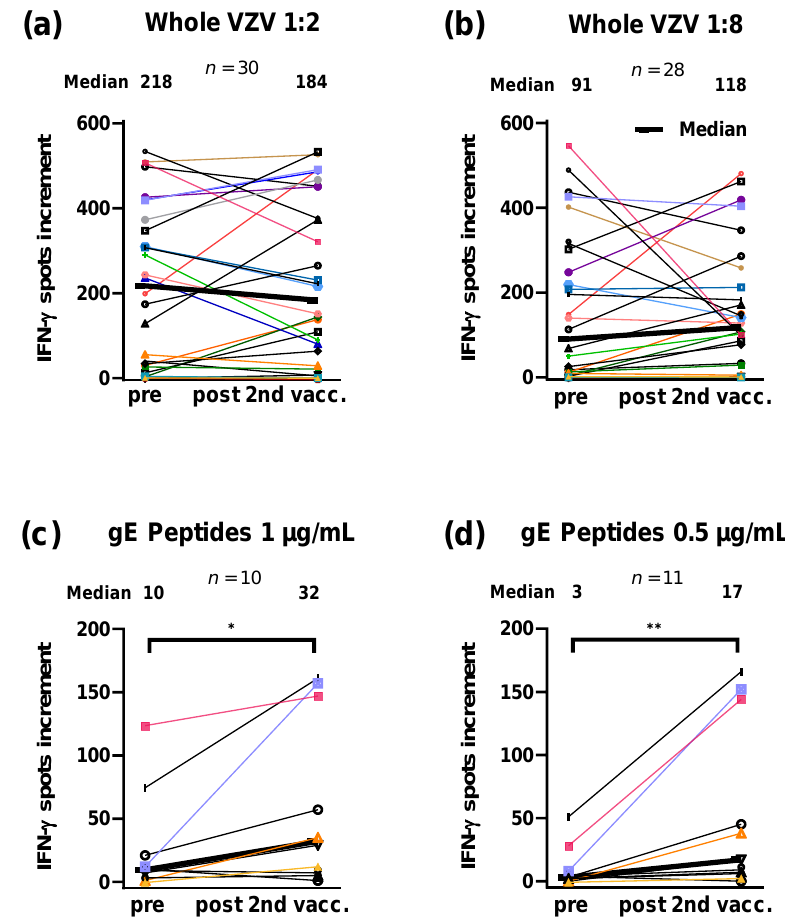
Figure 2. Individual time courses of varicella-zoster virus-specific immunity in hematopoietic stem cell transplant recipients tested prior to and post second vaccination with the adjuvanted, recombinant zoster vaccine Shingrix™. In this cohort, blood sampling was performed at a median of 33 months after transplantation. Vacc-vaccination with Shingrix™; Whole VZV-whole varicella-zoster virus antigen (Behring, dilution 1:2 and 1:8); gE-peptide pool of glycoprotein E (JPT, 1 and 0.5 µ g/mL per peptide). The bold black line connects the median values. Paired data were compared by Wilcoxon matched pairs test. * p < 0.05, ** p <